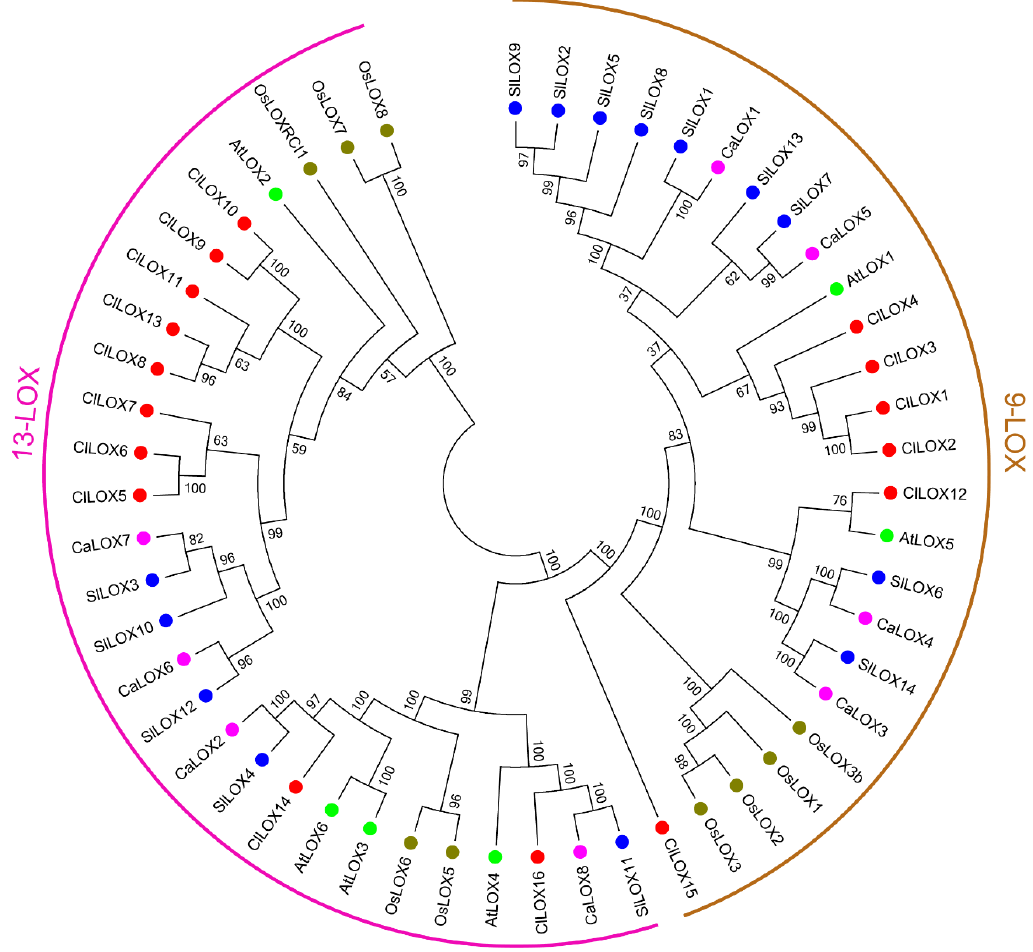
Figure 1. Phylogenetic analysis of LOX family members in watermelon and other plant species. The NJ phylogenetic tree was created based on the full-length amino acid sequences by using MEGA 7.0 with 1000 bootstrap replicates. The information of LOX proteins in various plant species is presented in Table S2.